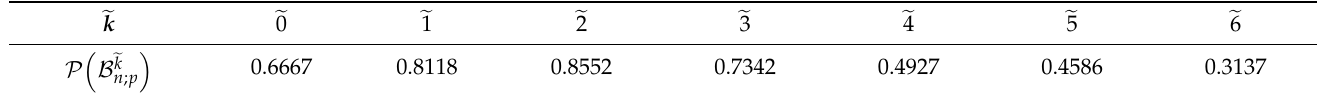
(cid:16) (cid:17) B (cid:101) k n ; p